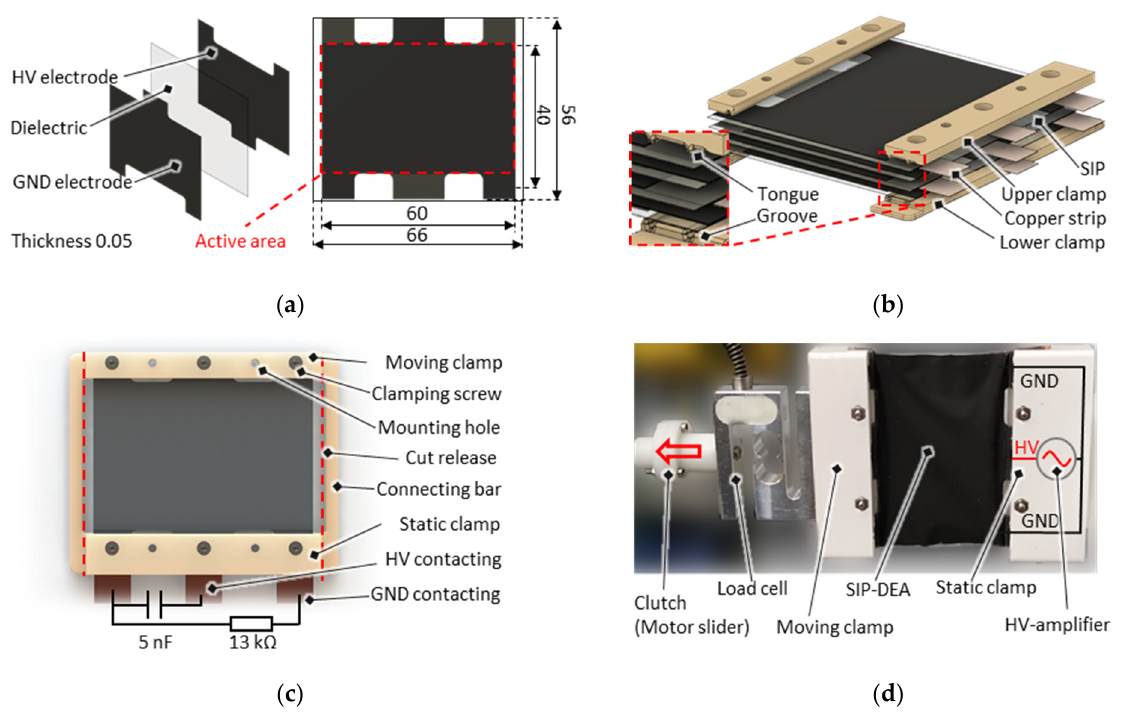
Figure 5. ( a ) Screen-print layout of the SIP which is alternately stacked with thin copper strips in a 4-layer layout, and sandwiched in between rigid clamps, as shown in ( b ) CAD explosion and ( c ) CAD assembly. ( d ) Photo of a cut-out sample mounted on a tensile test setup. ( c ) CAD assembly. ( d ) Photo of a cut-out sample mounted on a tensile test